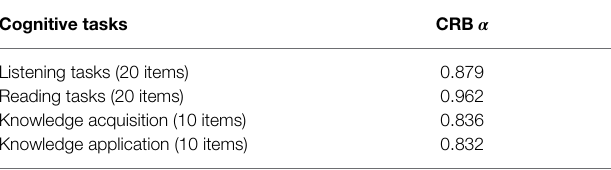
TABLE 1 | Internal consistency (CRB) of reading, listening, knowledge acquisition and knowledge application